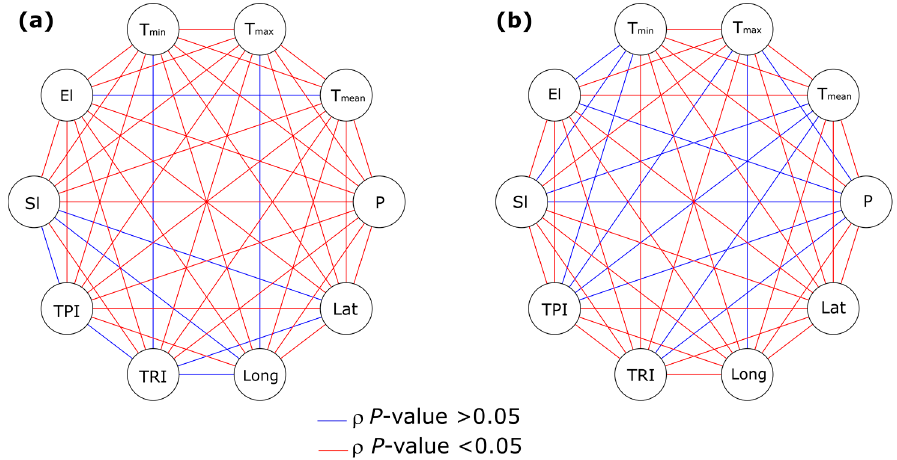
Figure 5. Circular correlograms showing the significance of all possible pairwise Spearman’s ρ coefficients calculated between environmental predictors, including latitude and longitude, in scenario ‐ 10 m ( a ) and scenario ‐ 500 m ( b ). For factors acronyms, see the main text.